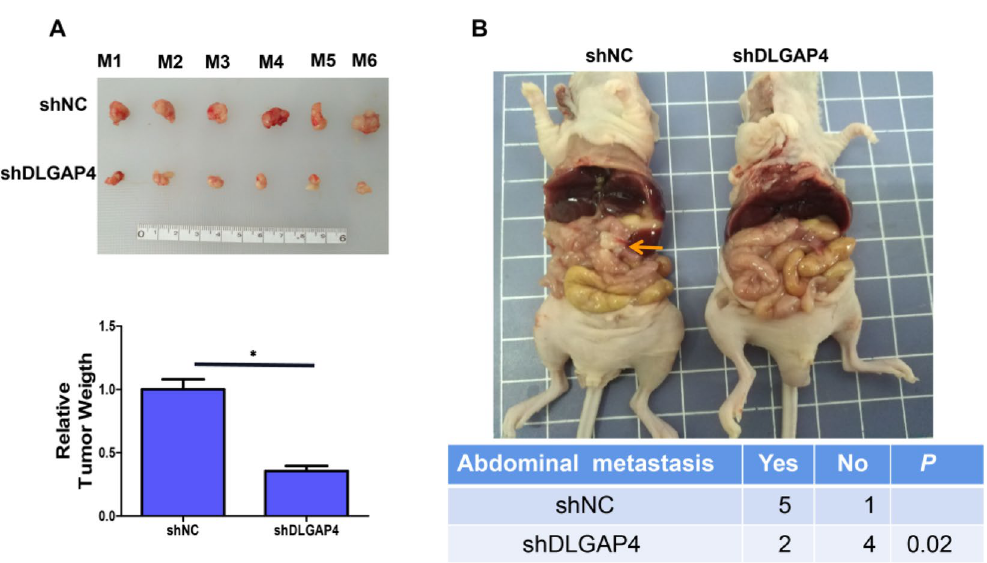
Figure 8. DLGAP4 knockdown suppresses the proliferation and growth of HCC cells in vivo. ( A ) Cells transfected with shNC or shDLGAP4 were injected into mice. Mice were sacrificed after 4 weeks. Tumours were harvested from sacrificed mice, and their weights were measured and compared between the two groups. ( B ) HepG2 cells transfected with shDLGAP4 or shNC were injected into the left ventricle of nude mice. Mice were sacrificed after 4 weeks. Representative images of abdominal metastases. Abdominal metastases and those without metastases are shown in this table. The data were obtained from the average of three independent experiments. *P <